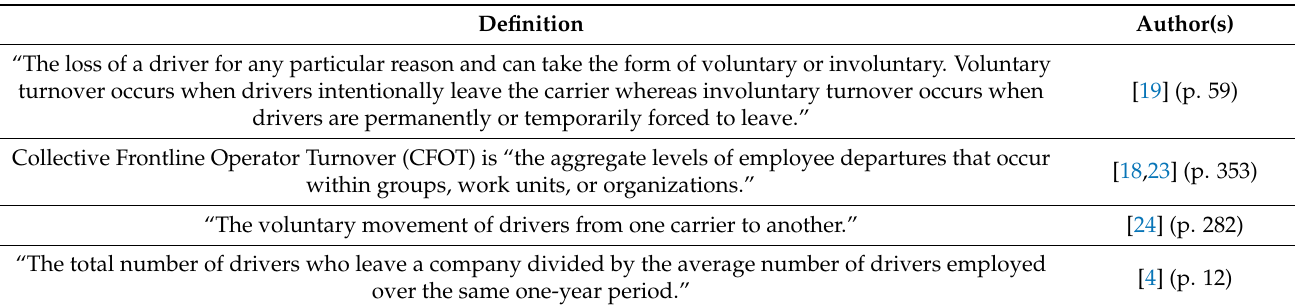
Table 1. Definitions of